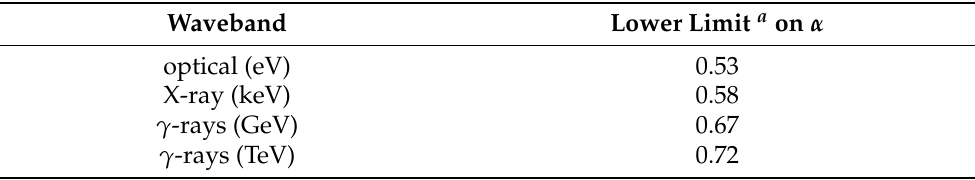
Table 1. Constraints on the spacetime foam parameter α